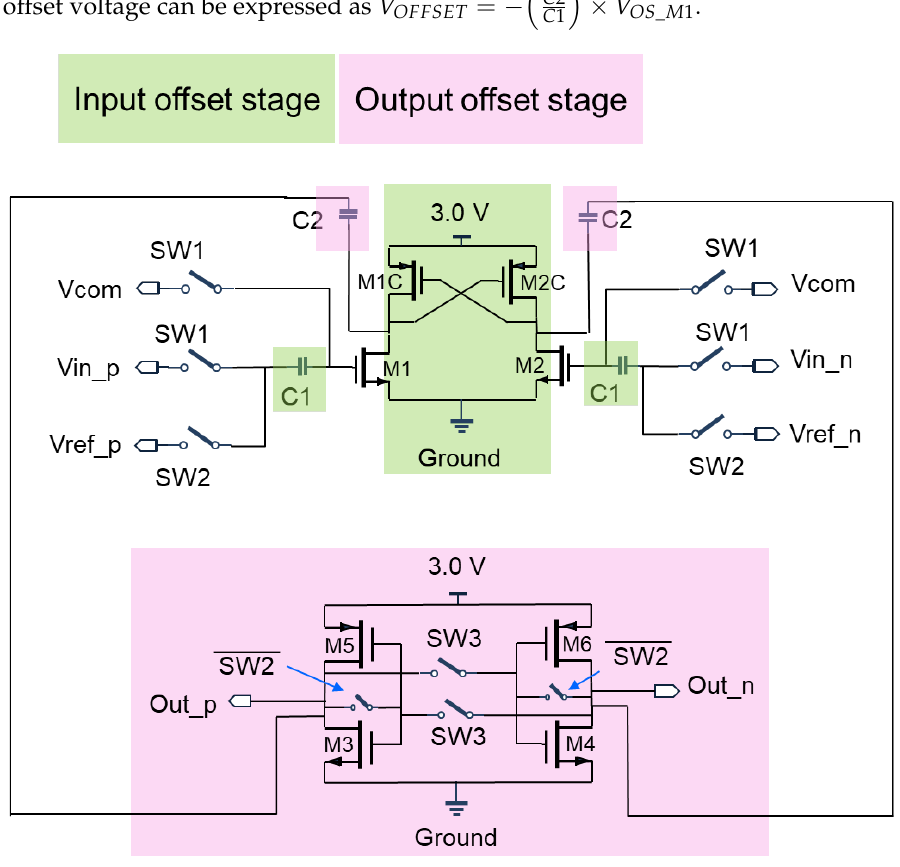
Figure 10. The proposed low offset comparator using dual offset technique. Input stage circuit sam- samples the input offset signal and hold by capacitance C1, output stage circuit read the data from